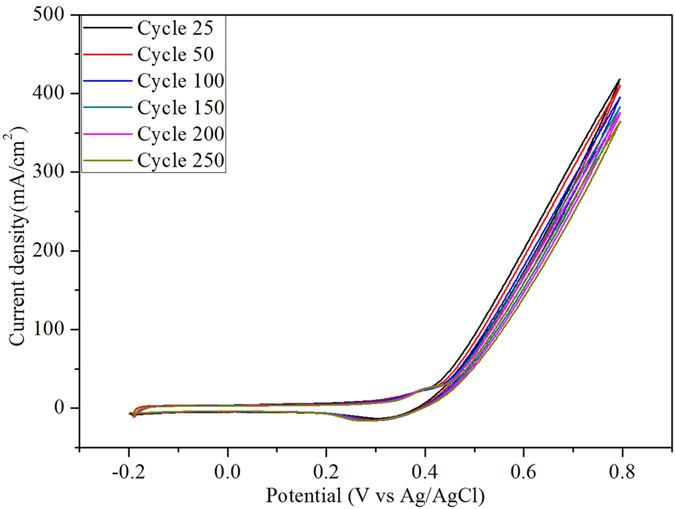
Cyclic voltammograms of NiCo2O4/MWCNT after 50, 100, 150, and 200 cycles at 100 mV/s in 1.0 M KOH with 6.0 M MeOH.